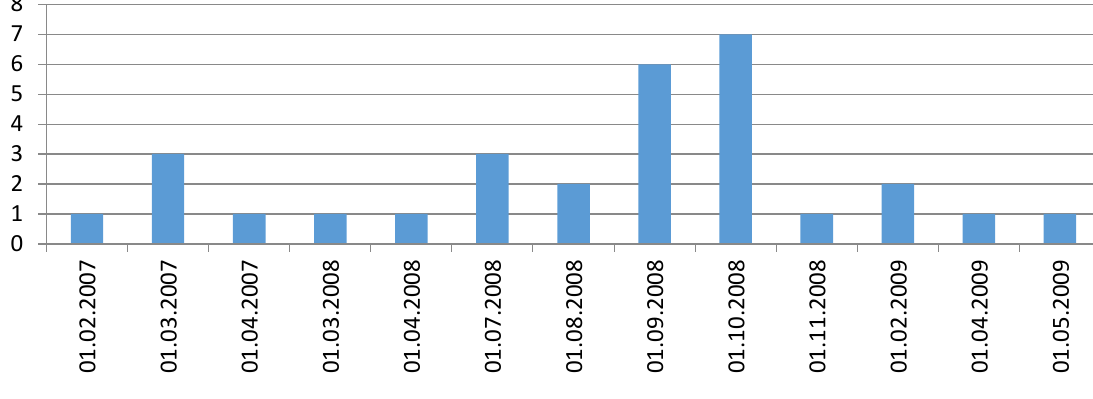
Figure 5. Frequency of overreactions in the PFTS index over the period 2007–2009 (monthly